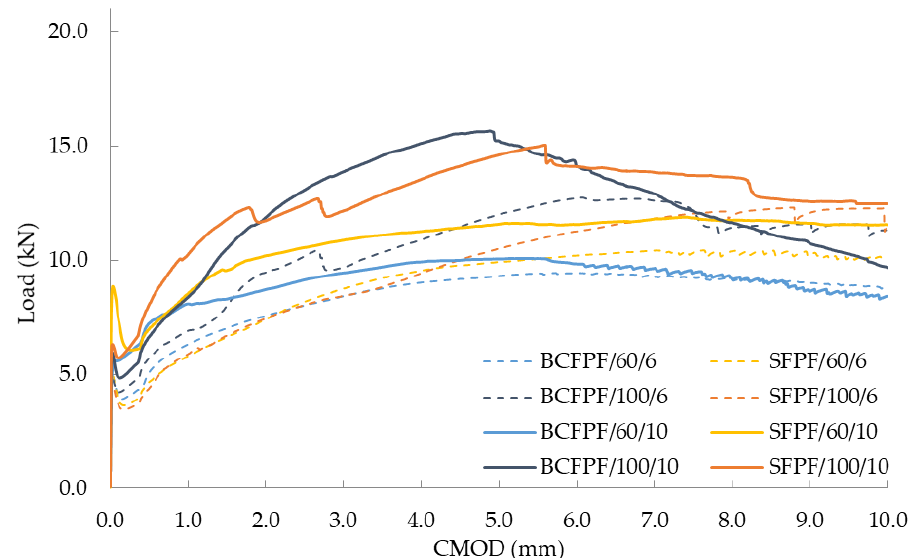
Figure 7. Load—CMOD (crack mouth opening displacement) relationship graphs for 450/1.2 matrix after 28 days of curing.